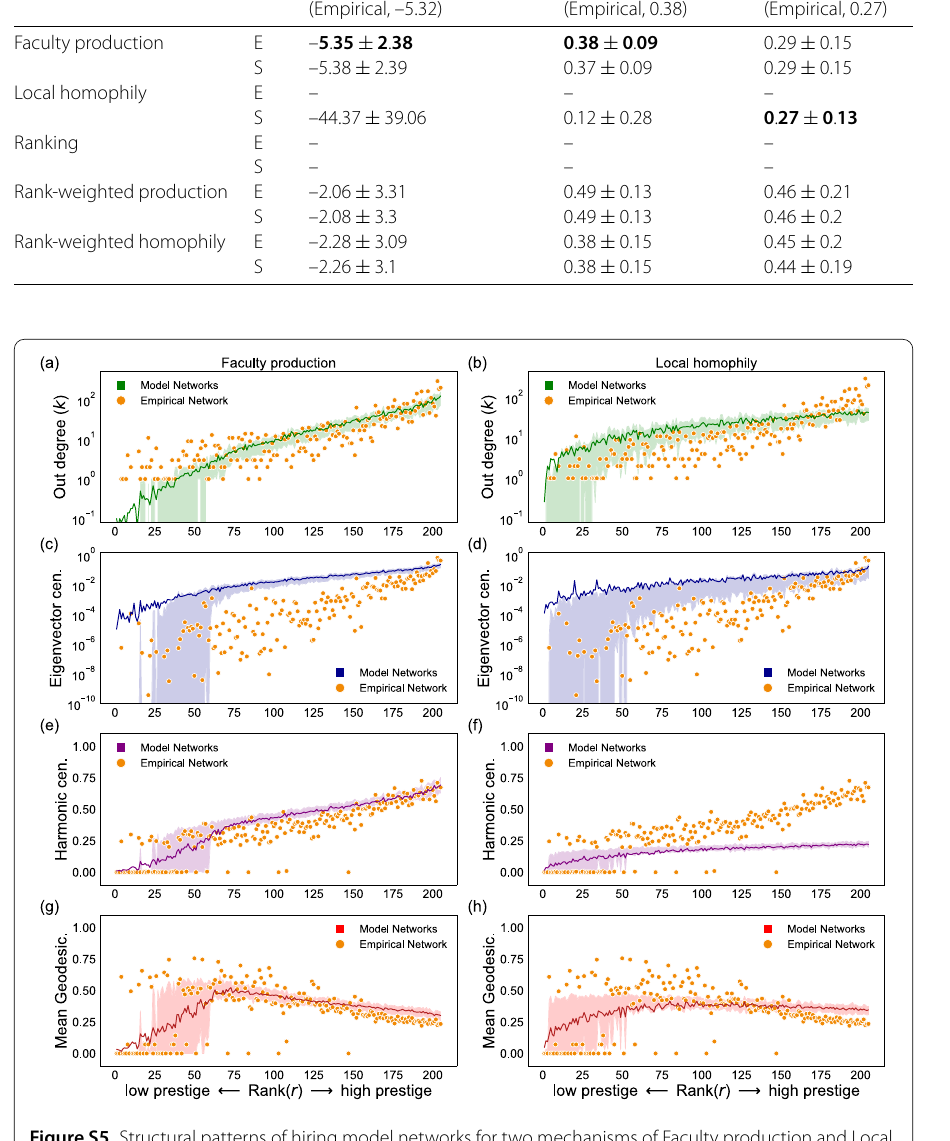
Table S6 Mean value of network summary statistics for five hiring models vs. the empirical values for History. Mean values of the three network summary statistics—eigenvector centrality, harmonic centrality, and normalized mean geodesic distance—for networks produced by each of the five hiring models vs. the corresponding values of the empirical History network. Boldface values are close to the empirical value. Uncertainty indicates the average absolute distance between predicted and empirical value. For this comparison, parameter combinations achieving the closest structural inequality are applied when β = 1.0 (Table S4). Two initializations (Init.) of Egalitarian (E) and Skewed (S) are used. Dashed line represents the Ranking and Local homophily model are unable to reproduce realistic structural inequalities. All values are rounded to the second digit Hiring Model Init. Eigenvector centrality (log) Harmonic centrality (Empirical, –5.32) (Empirical, 0.38)